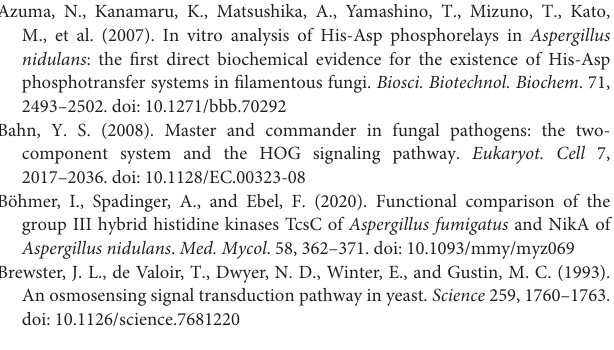
Supplementary Figure 2 | Localization of GFP-Skn7 (A–B ′′ ) and SskA-GFP (C–D ′′ ) in normal hyphae (A–A ′′ , C–C ′′ ) and hyphae treated for 4h with 1 µ g/ml